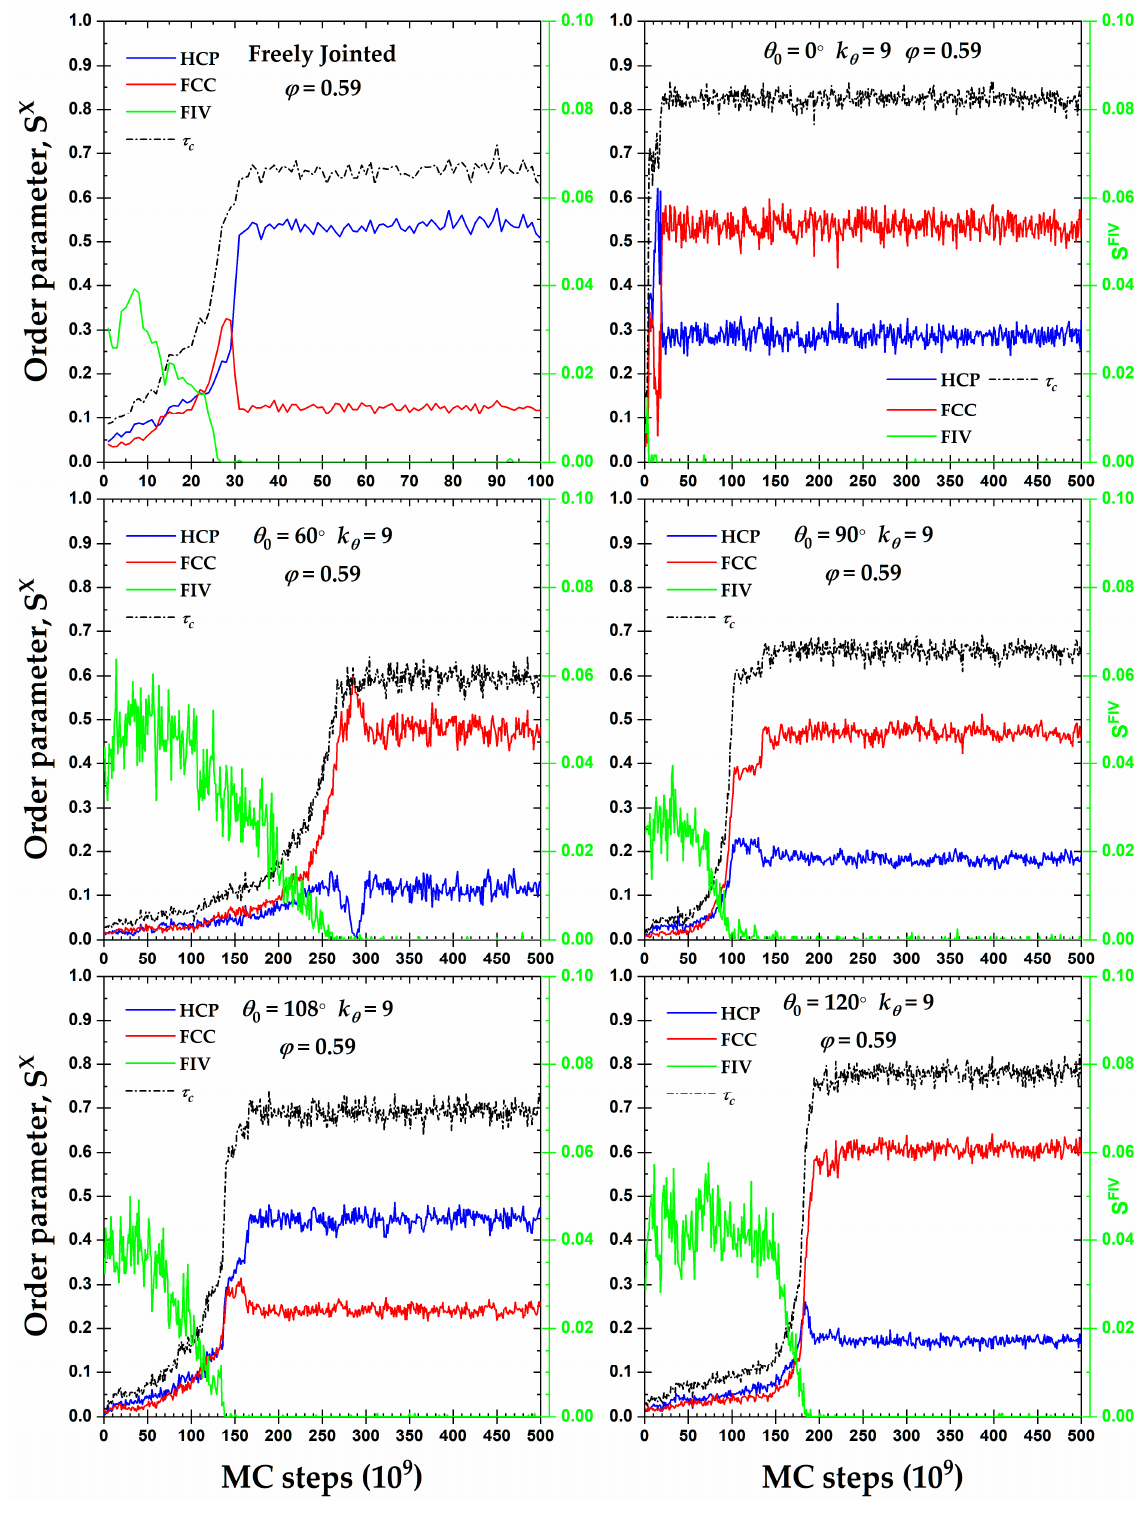
Figure 6. Crystal nucleation and growth, as quantified by the evolution of the HCP, S HCP , and FCC, S FCC , order parameters (( left ) y -axis), and fraction of fivefold-like sites, S F I V (( right ) y- axis), as a function of MC steps for 100-chains N av = 12 systems of freely-jointed chains and semi-flexible chains with bending constant k θ = 9 and equilibrium bending angle θ 0 = 0, 60, 90, 108, and 120 ◦ at a packing density 𝜑 = 0.59 .